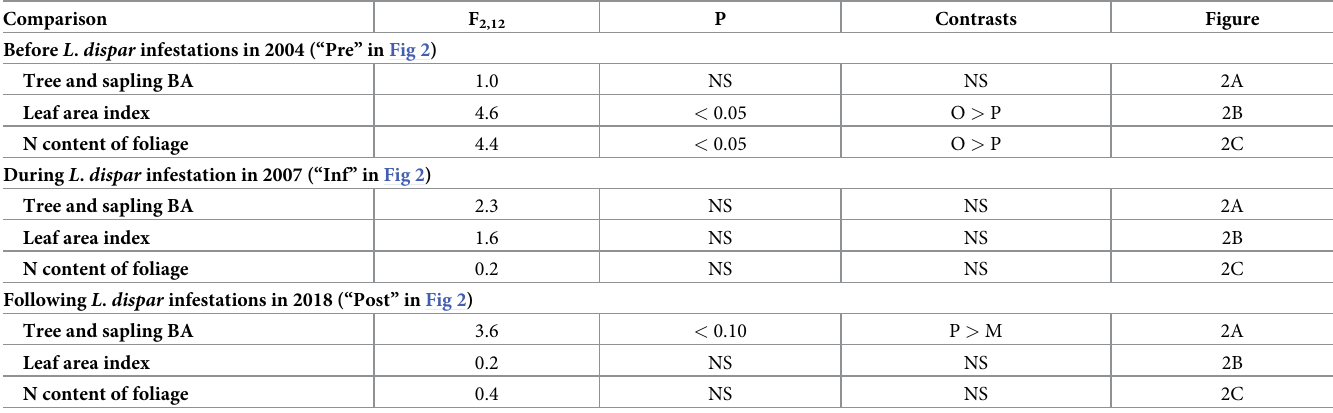
Table 1. Results of ANOVA and Tukey’s HSD analyses for structural characteristics of forests infested by L . dispar . Comparison